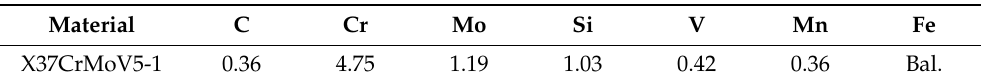
Table 1. Chemical composition of the welding wire made of AISI H11 (X37CrMoV5-1, 1.2343) determined using spark-OES and combustion gas analysis (the latter for C only). All values are given in mass-%. Material C Cr Mo Si V Mn Fe X37CrMoV5-1 0.36